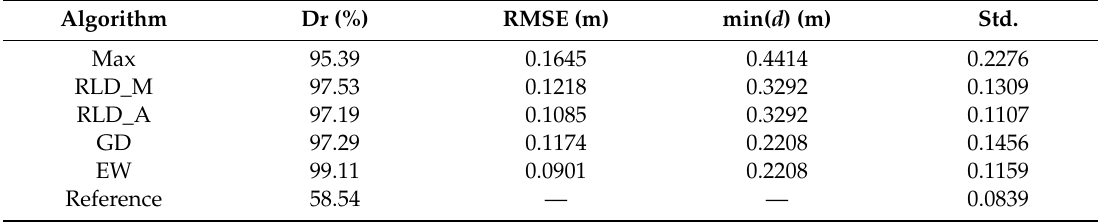
Figure 16. Locations of the water surface on the selected profile from: ( a ) reference data; ( b ) Max; ( c ) RLD_M; ( d ) RLD_A; ( e ) Gaussian decomposition (GD); and ( f ) EW. Table 2. Performance assessments for surface detection results with field